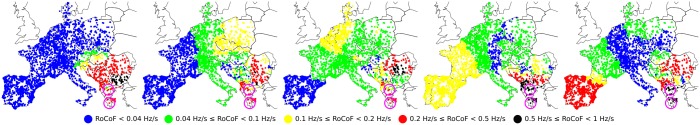
Spatio-temporal evolution of local RoCoFs for two simultaneous abrupt power losses, each of ΔP = 1500 MW in a moderate load (and thus low inertia, typical of a standard summer evening) configuration of the synchronous grid of continental Europe of 2018.The faults location is indicated by purple circles. Panels correspond to snapshots over time intervals 0-0.5[s], 0.5-1[s], 1-1.5[s], 1.5-2[s] and 2-2.5[s] from left to right.